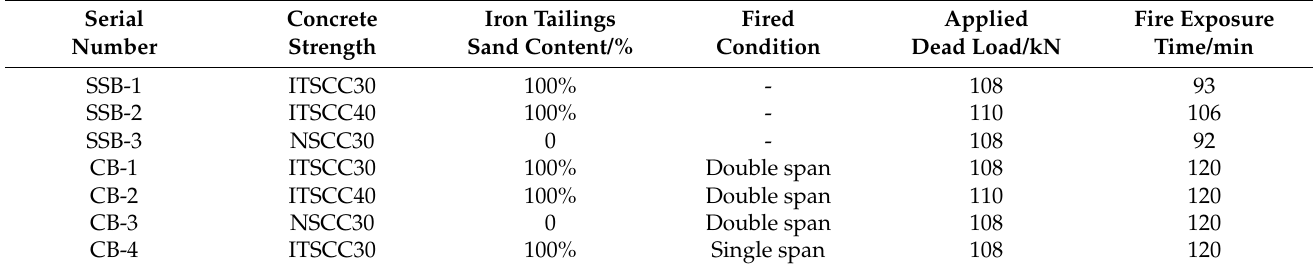
Table 1. Design parameters of beams.